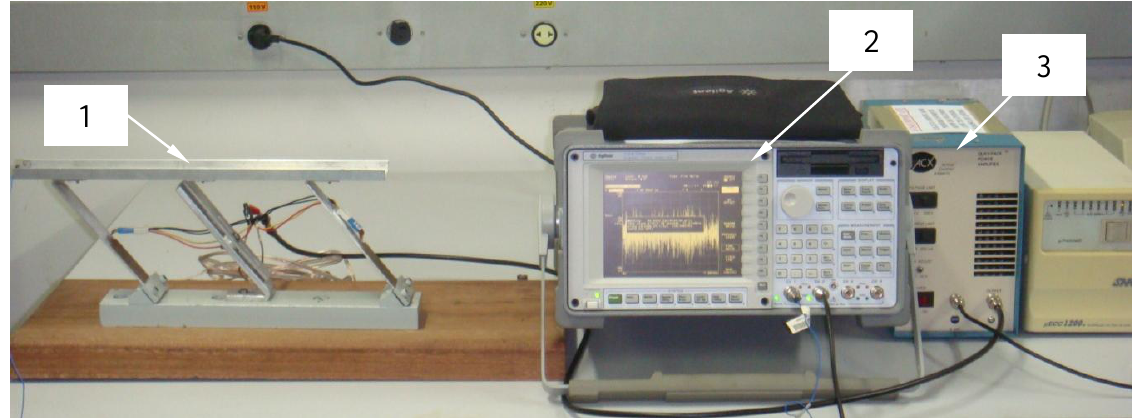
Figure 5. Illustration of the experimental setup.